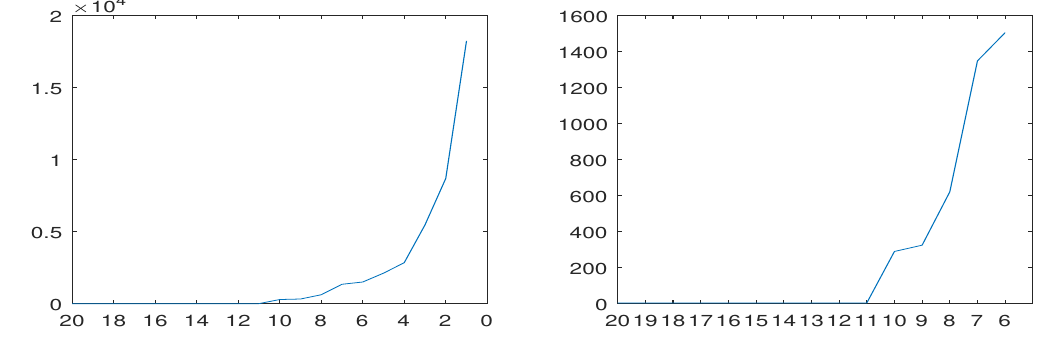
Figure 3: Left side: | λ 20 ( A n ) | < ··· < | λ 1 ( A n ) | ; right side: | λ 20 ( A n ) | < ··· < | λ 6 ( A n ) | in a typical realization in Example